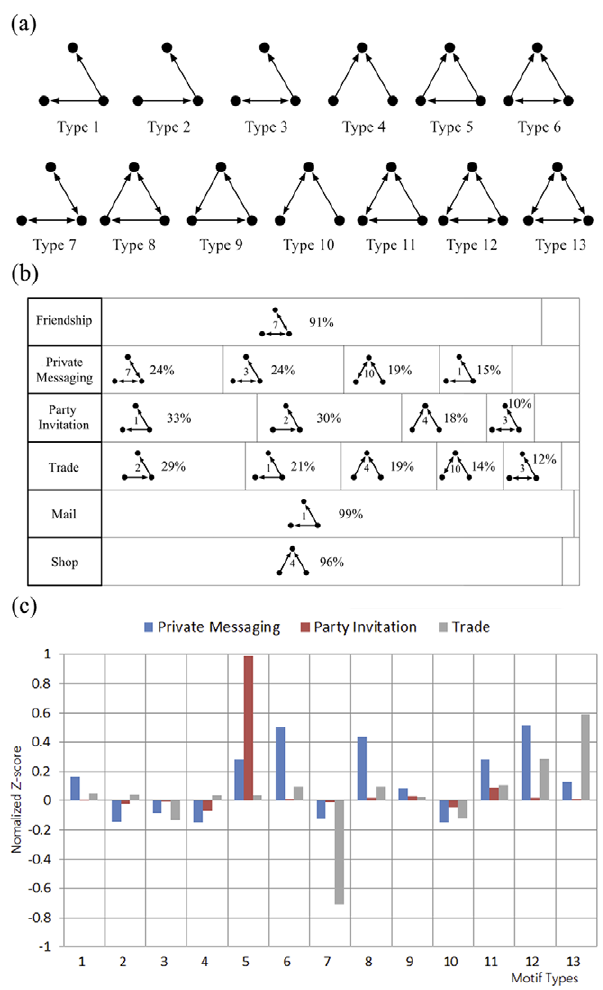
Figure 5. Network motif analysis of node triplets reveal detailed interactions patterns in directed networks. (a) The thirteen possible motifs composed of three nodes in a directed network. (b) The fractions of each motif type in each of the six networks. Motifs accounting for fewer than 10% of the motifs are not shown. Friendship, Mail, and Shop each show one dominant motif, consistent with the high or low reciprocity found in the networks. (c) A closer look at the (normalized) Z-score triad census of Private Messaging, Party Invitation, and Trade networks where no dominant motif is evident, we used the Z-score method is employed to determine significantly over- and underrepresented triangular motifs. Overrepre- sented motifs (with ~ ZZ w 0 : 4 ) are indeed closed triangles, consistent with the relatively high clustering tendencies in these networks.